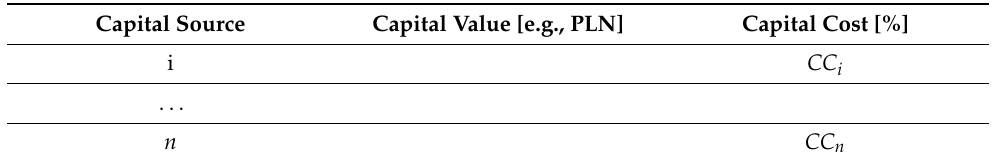
Table 3. List of available capitals and costs of their obtaining for financing a project. Source: designed by authors.